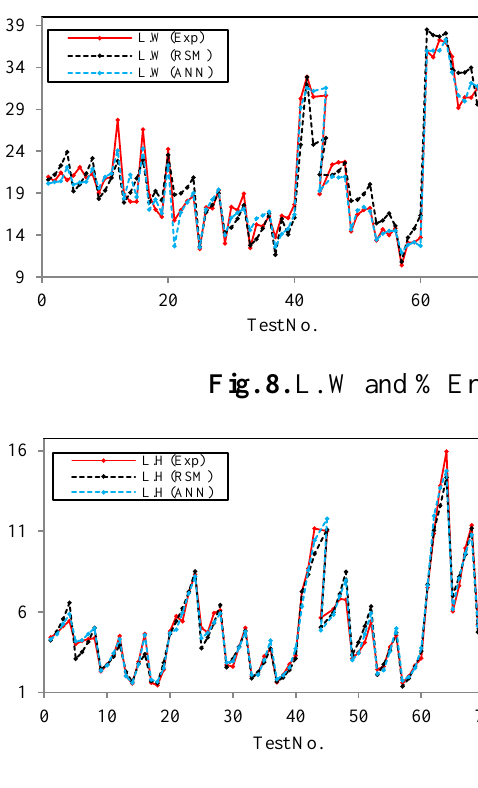
Fig. 9. L. H and % Errors comparison for the ANN and